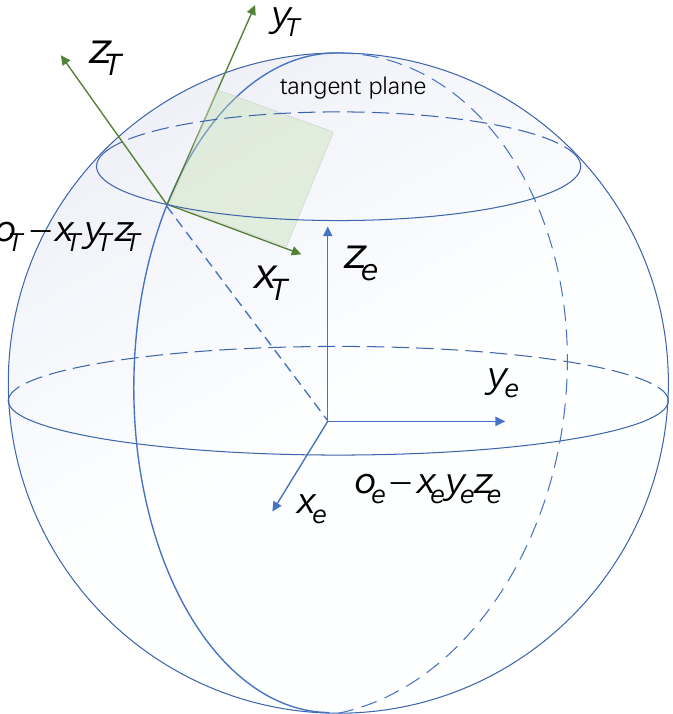
Figure 6. Inherent geometry constraint between o − x